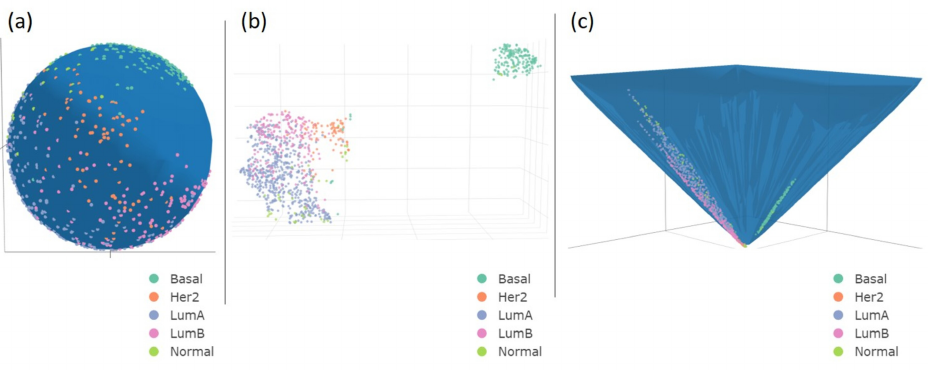
Figure 2. A 3D visualization of UMAP projection (NN = 65). The pictures show 1084 samples grouped by five BC subtypes on a spherical surface ( a ), Euclidean space ( b ), and hyperboloid ( c ). The input RNA-seq data comprised 20,530 genes. We reduced it to three dimensions for Euclidean space and two dimensions for spherical and hyperbolic